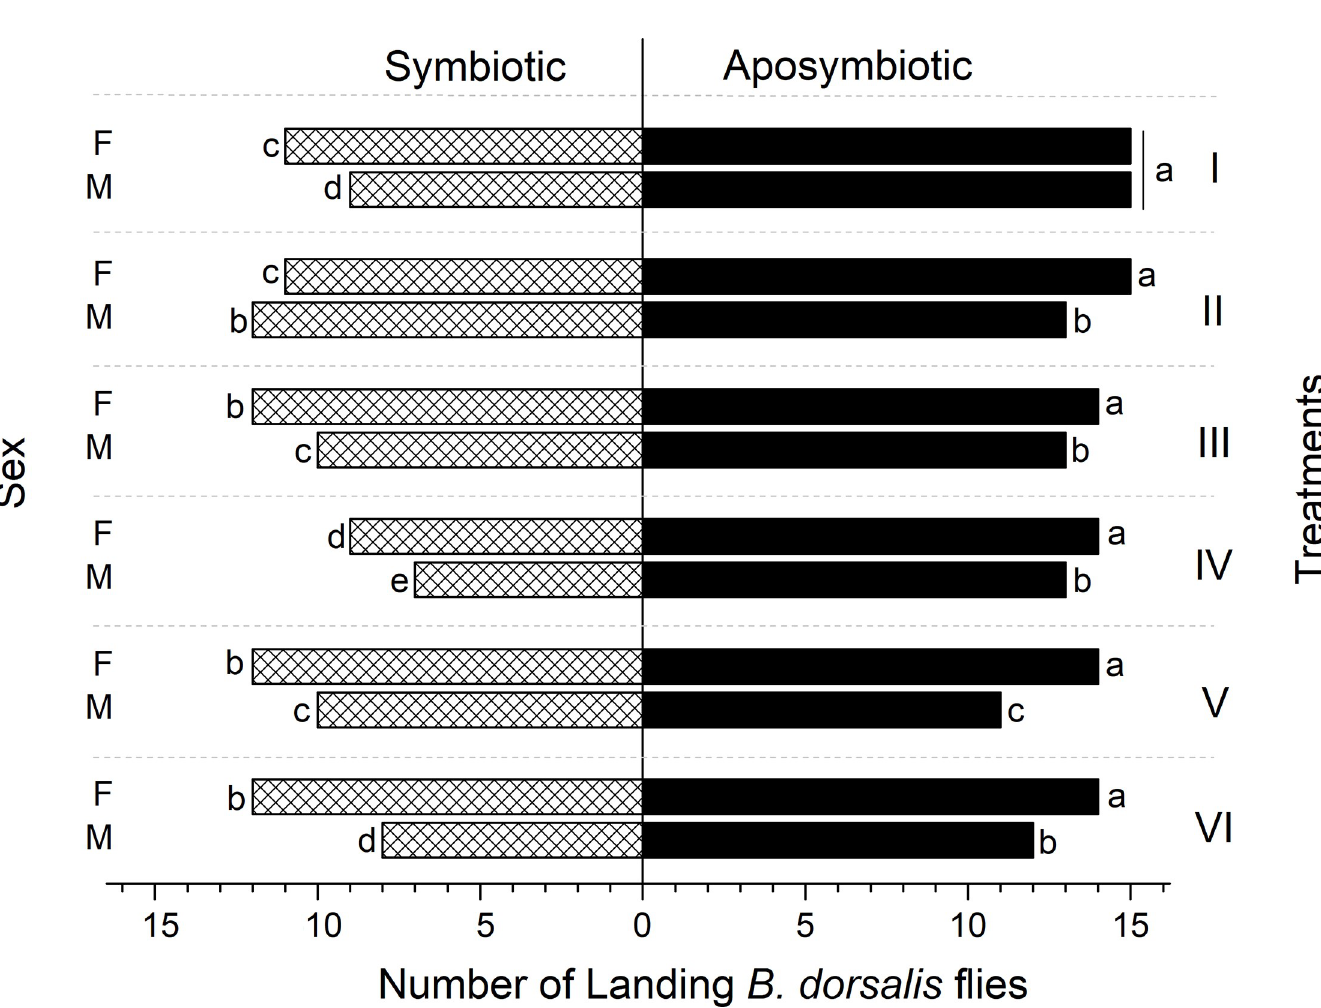
Fig 2. Response parameters of Bactrocera dorsalis females to experimental diets. Each response datum consisted of the overall number of flies which landed in different treatments regardless the diet quality or drop